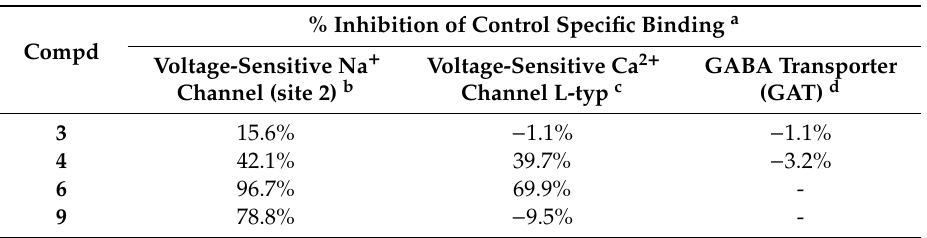
Table 4. In vitro binding / functional assays (concentration 100 µ